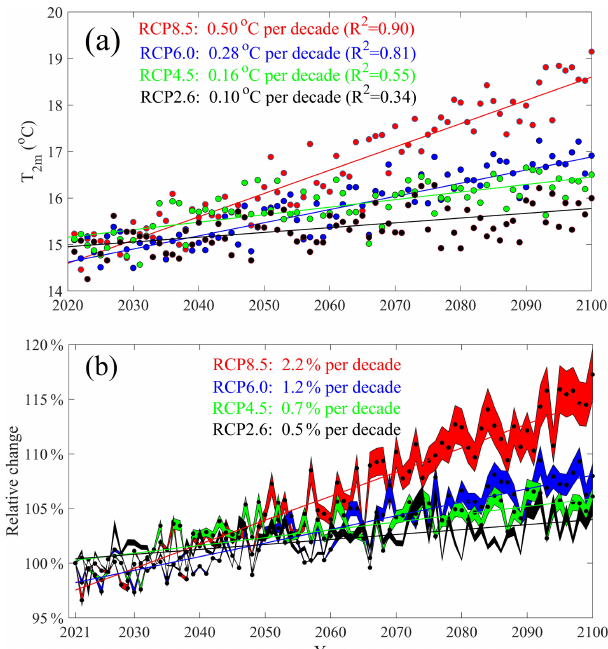
Figure 8. (a) Annual air temperature from the year 2021 to 2100 for four different global warming scenarios for Hangzhou. (b) The pro- jected relative change in waste treatment CH 4 emissions (or EFs) for Hangzhou; note the shading indicates the extent of the three